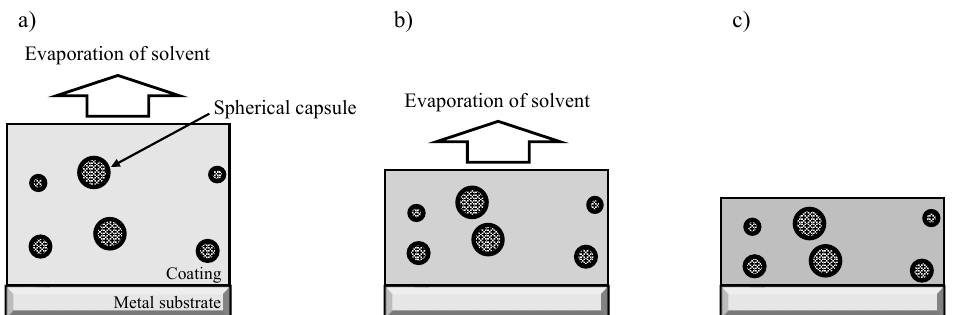
Figure 10. Schematic illustration of the structural changes of the self-healing coating with dispersed spherical capsules (SHC-SC) during aging. ( a ) Just after coating the mixture of prepolymer/ethylene glycol/spherical capsules/cyclohexanone. ( b ) While aging, the reaction of the prepolymer with ethylene glycol and the evaporation of cyclohexanone. ( c ) In the last stage of aging, polyurethane and film thinning formed, which led to an increase in capsule density.